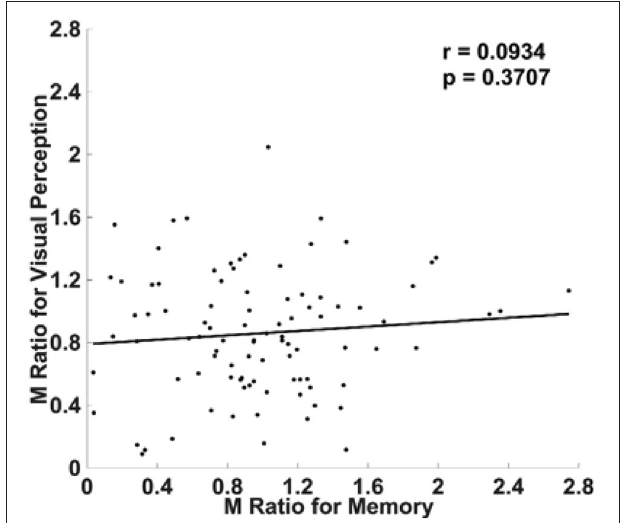
FIGURE 4 | No correlation between visual and memory metacognitive efficiency when both tasks involved YN judgments. We did not find a correlation between visual and memory metacognitive efficiency when both tasks involved YN rather than 2AFC judgments. Metacognitive efficiency was quantified using M Ratio (see section Materials and